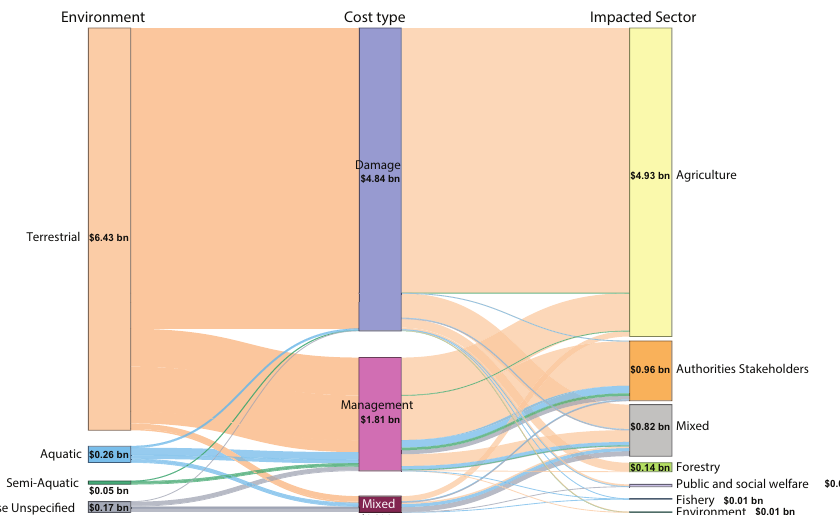
Figure 1. Alluvial plot illustrating flows of identified invasion cost types in the UK amongst environ- ments and socioeconomic sectors. Abbreviations: bn is billion (2017 US$).